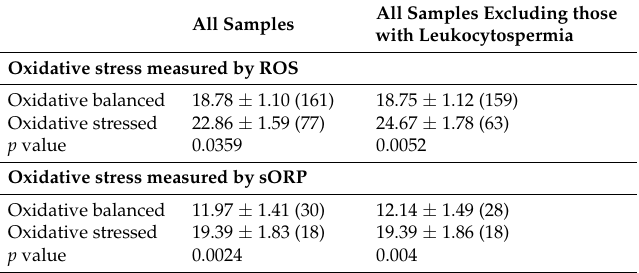
Table 2. Sperm DNA fragmentation in the presence and absence of oxidative stress. All Samples Excluding those All Samples with